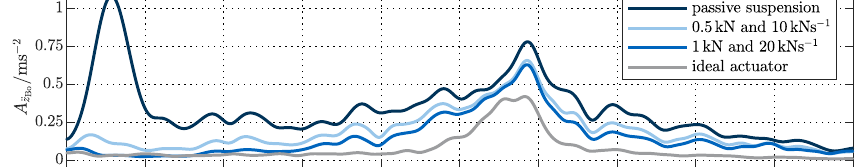
Figure A7. FFT of dynamic wheel-load for the AB profile at 45kmh − 1 .